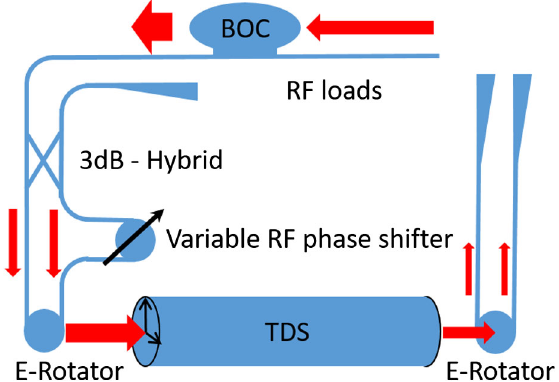
FIG. 2. Conceptual layout of the TDS with variable polariza-